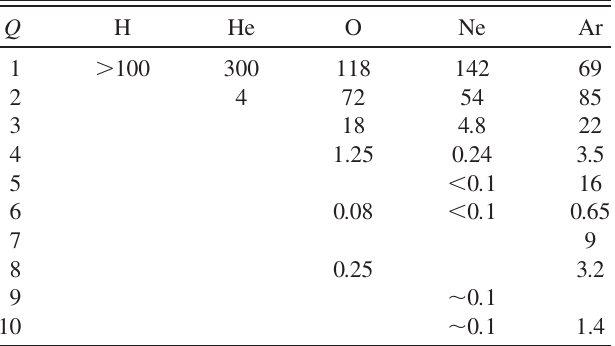
TABLE I. Absolute ion intensities measured by Faraday cup (unit: (cid:1) A ).